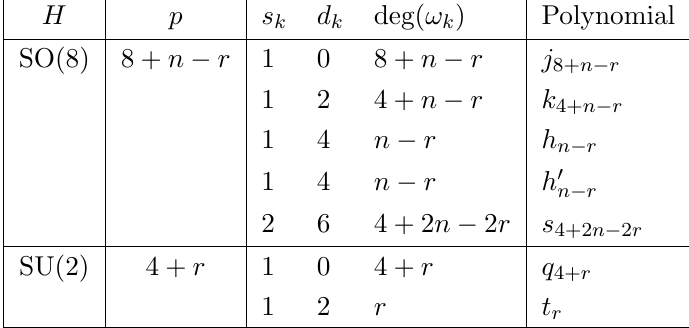
Table 10 . Looijenga’s